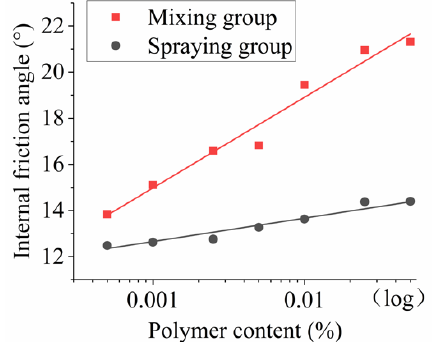
Figure 9. The relationship between the internal friction angle and polymer content.